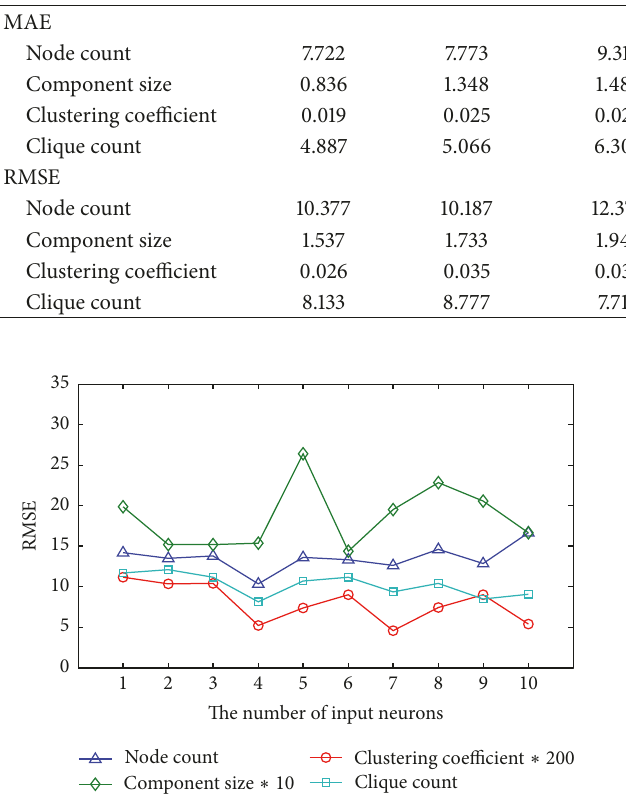
Figure 8: Dependence of RMSE on the number of neurons in the input